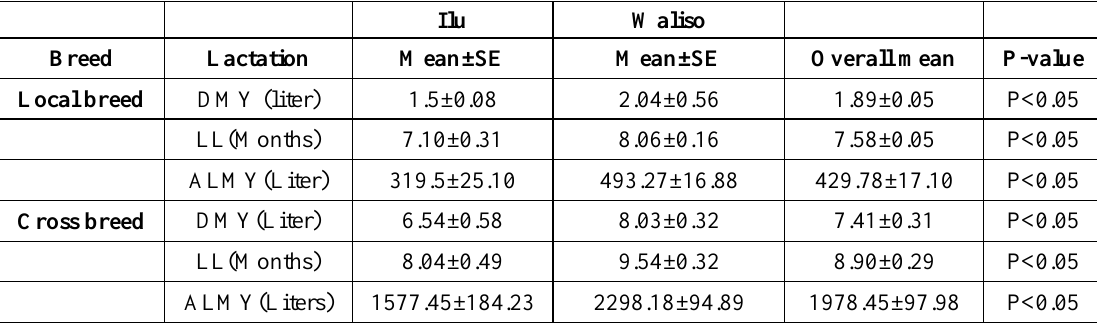
Table 1. Lactation performance of dairy cows in the study